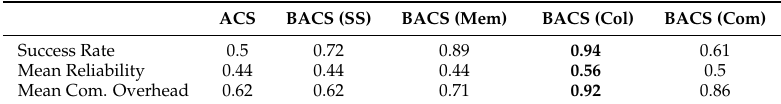
Table 1. A summary of the performance of the algorithms across all instances. The results highlighted in boldface are statistically significant. ACS BACS (SS) BACS